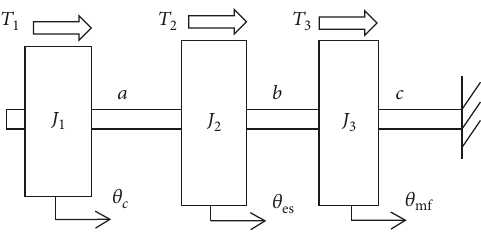
Figure 6: Schematic drawing of the physical